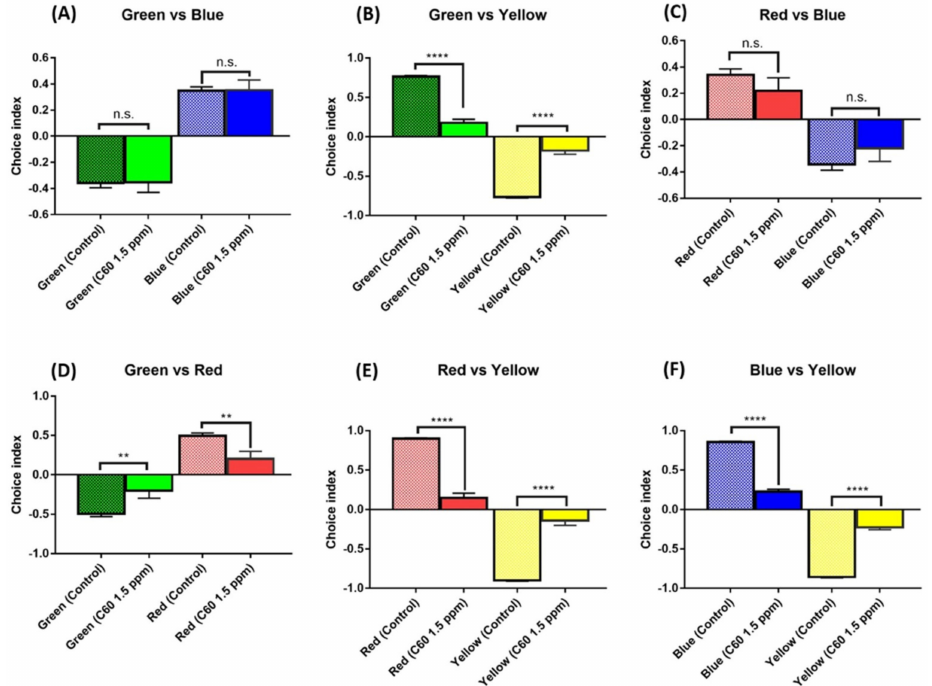
Figure 10. Comparison of color preferences between control and C 60 NPs-exposed zebrafish after 12-day exposure. ( A ) Green vs. blue combination, ( B ) green vs. yellow combination, ( C ) red vs. blue combination, ( D ) green vs. red combination, ( E ) red vs. yellow combination, ( F ) blue vs. yellow combination. Data were analyzed using one-way ANOVA followed by the Tukey post-hoc test. If